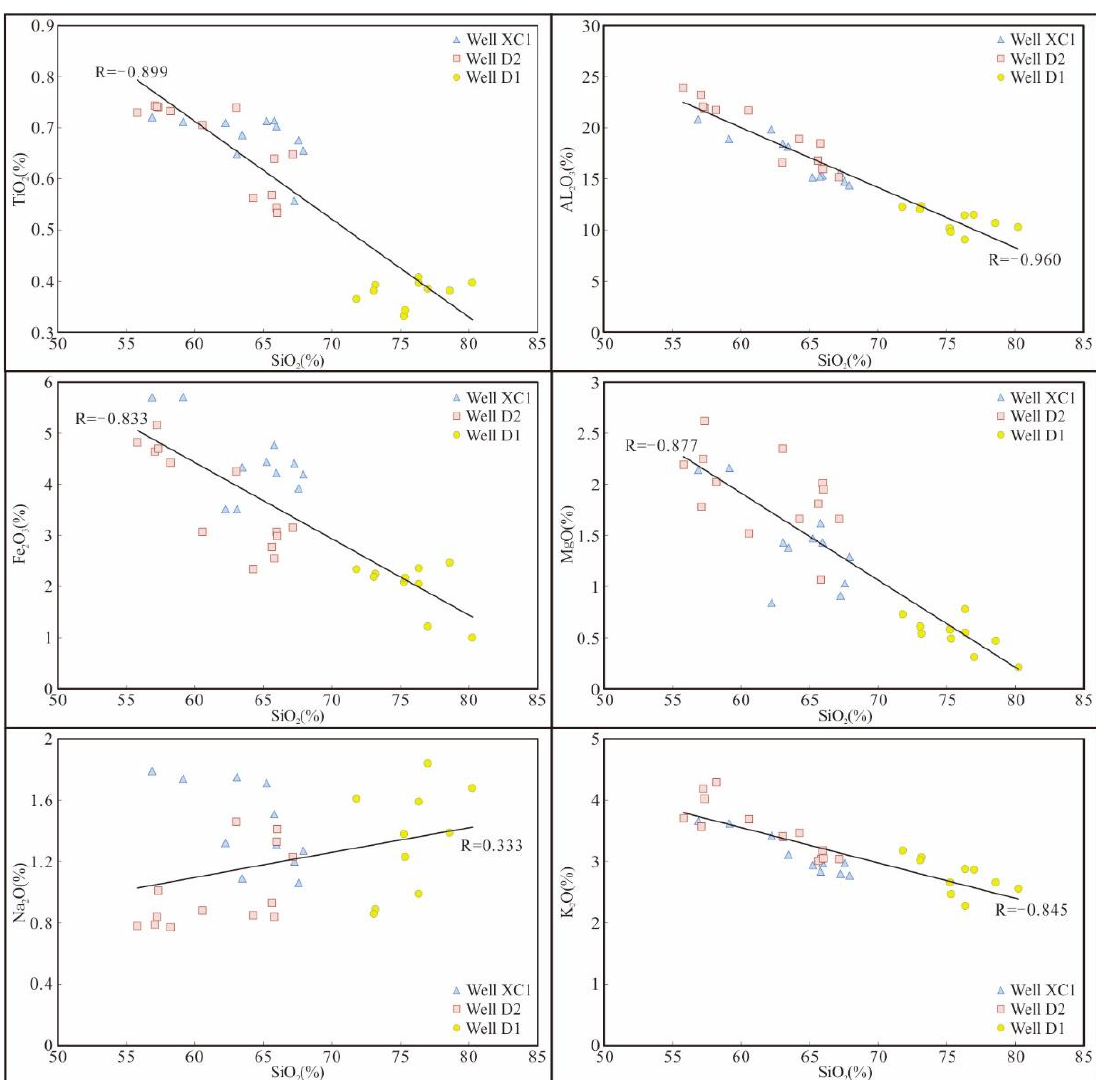
Figure 2. Harker variation diagrams for Wudun sag samples.